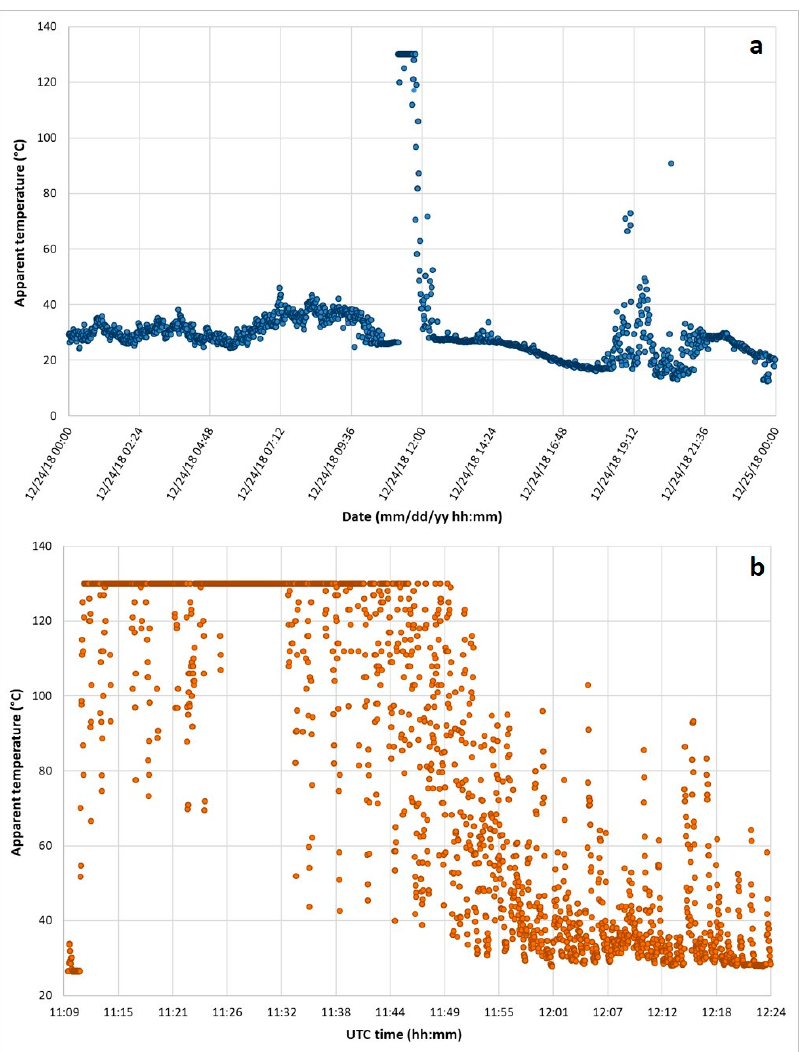
Figure 4. ( a ) Maximum apparent temperature (°C) at one minute time lapse recorded by the ENT thermal camera during the whole day on 24 December 2018, displaying the first thermal anomalies at ~07:10 (ash emission from the summit craters), the lava fountain phase (with saturated values between 11:12 and 11:39), and the explosions from Bocca Nuova crater recorded between 18:58 and 20:27. ( b ) Maximum apparent temperature (°C) at two seconds time lapse recorded by the ENT thermal camera between 11:09 and 12:24, showing the lava fountain phase (between 11:11 and 11:48) with a mostly saturated apparent temperature scale (130 °C), and a gradual maximum apparent temperature decline during the following Strombolian explosive phase.